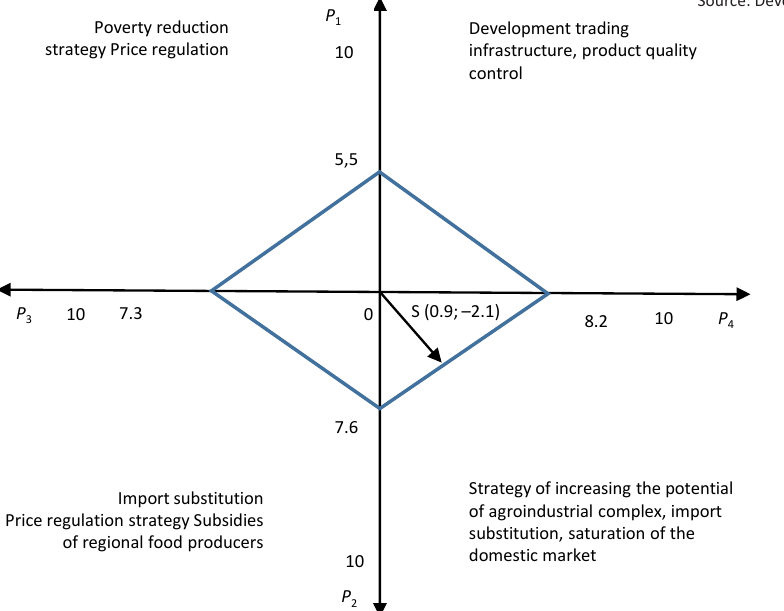
Source: Developed by the authors.